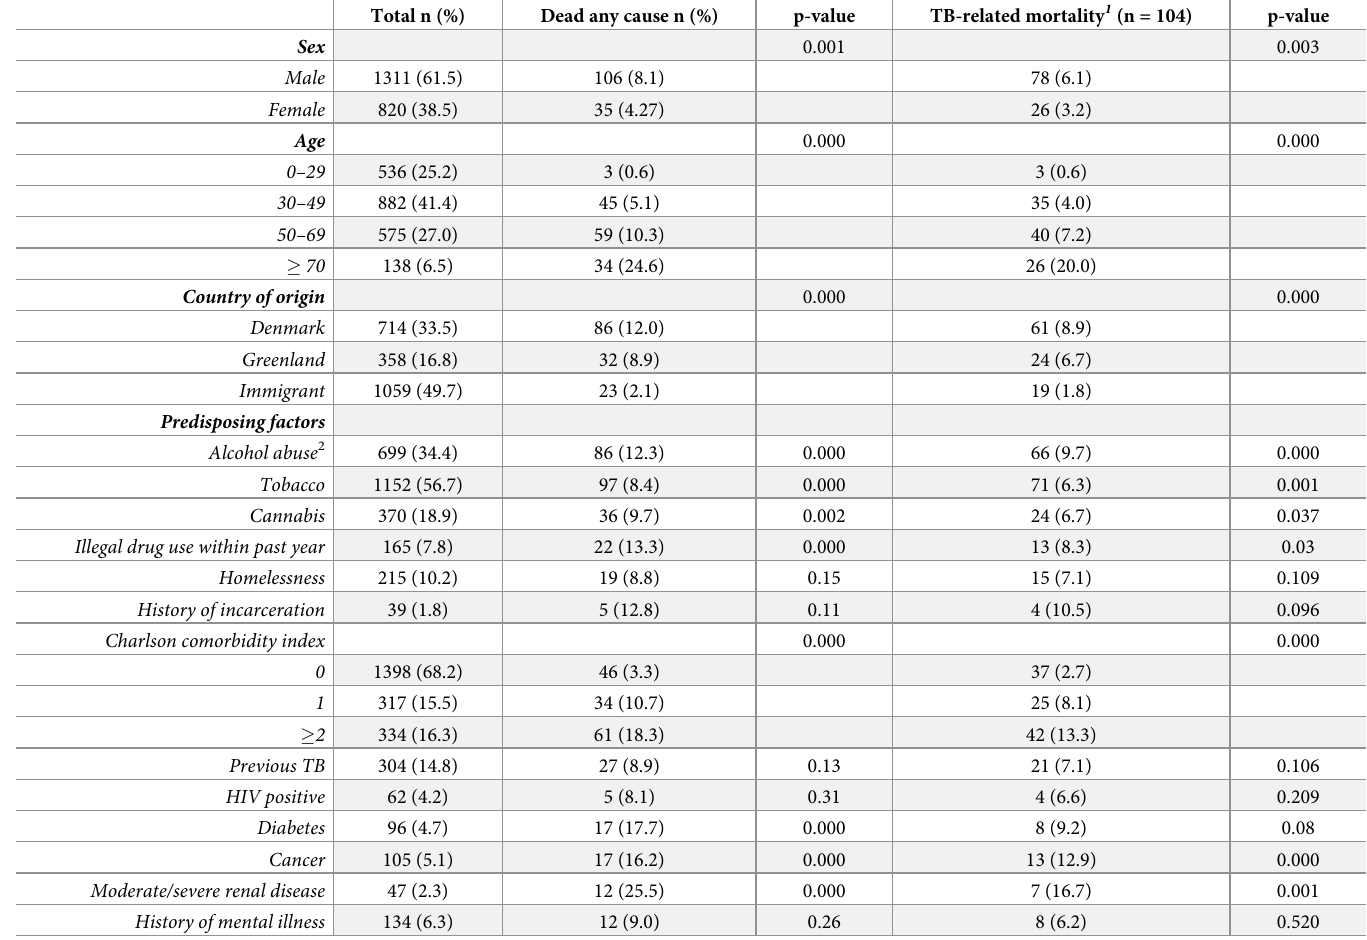
Table 1. TB related mortality 1 and overall mortality, by sociodemographic risk factors among patients with TB in Denmark 2009–2014.